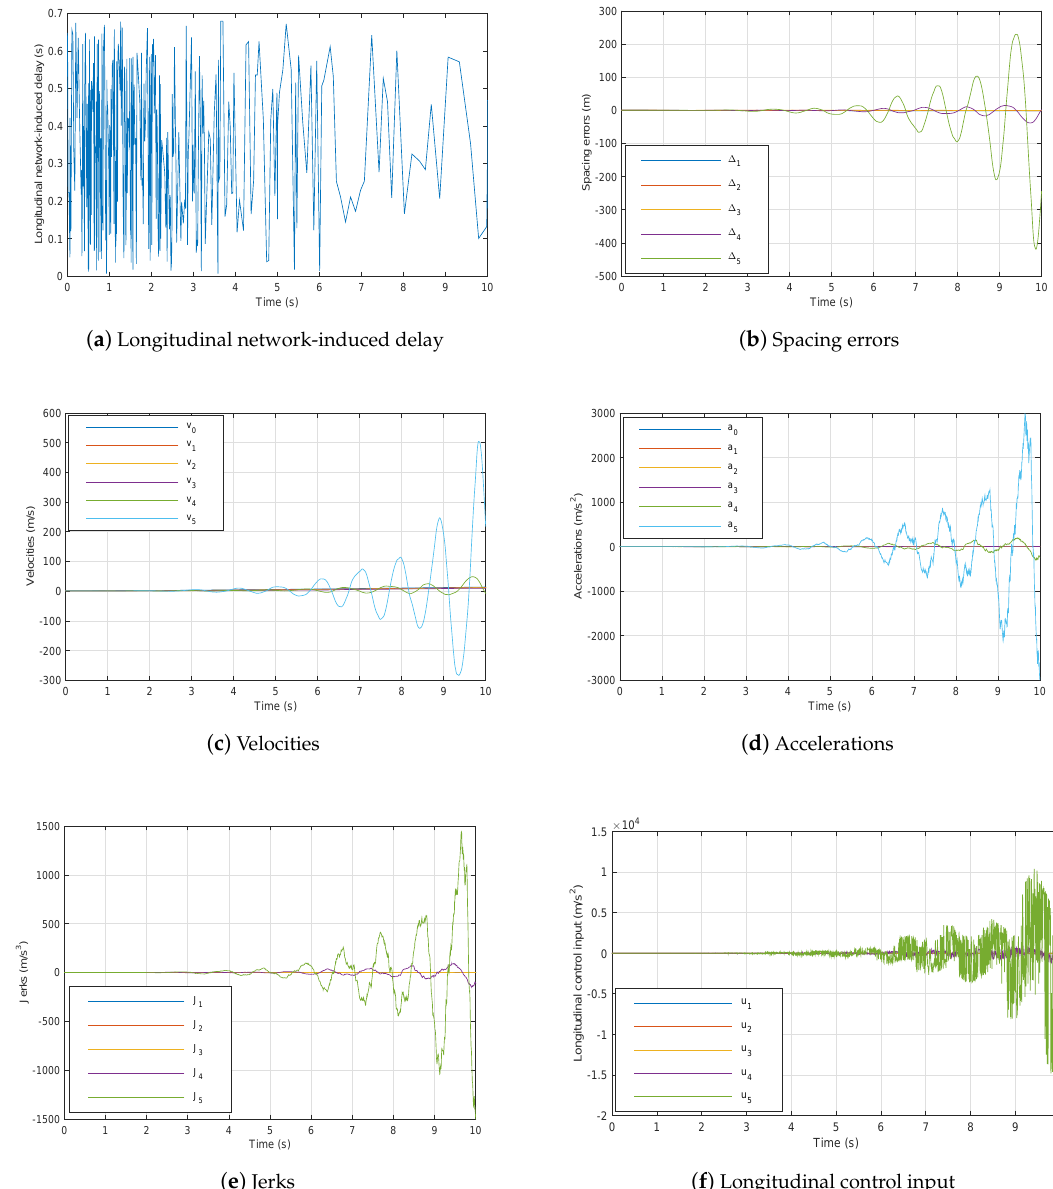
Figure 7. Six-vehicle platoon system under controller (49) through the communication network with h d =